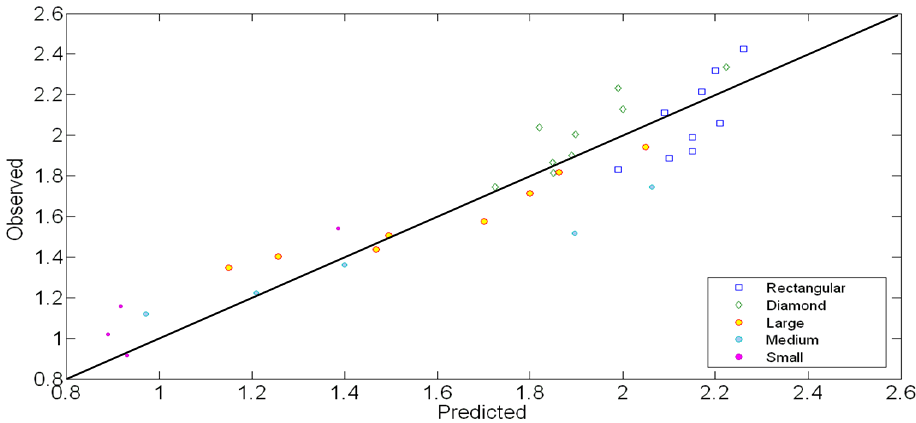
Figure 7. Scatter diagrams around perfect line for different types of